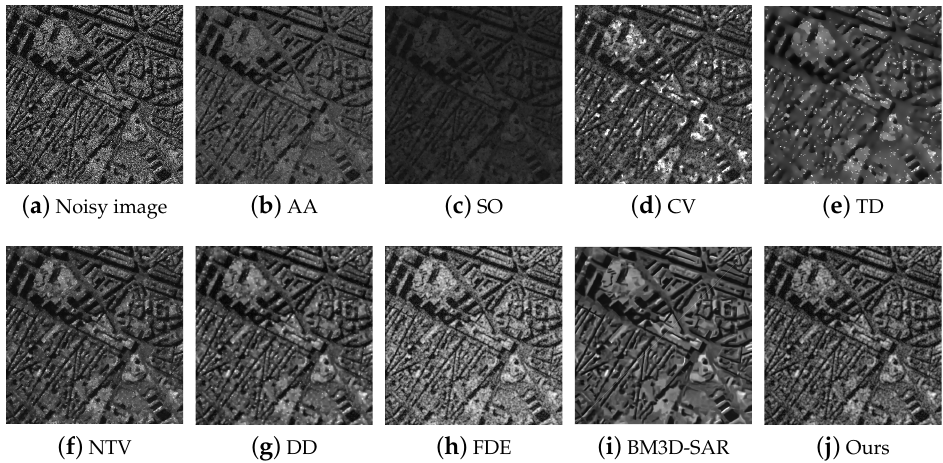
Figure 4. The despeckled results on the texture2 image: ( a ) Noisy: L = 1. ( b – j ) Despeckled results.